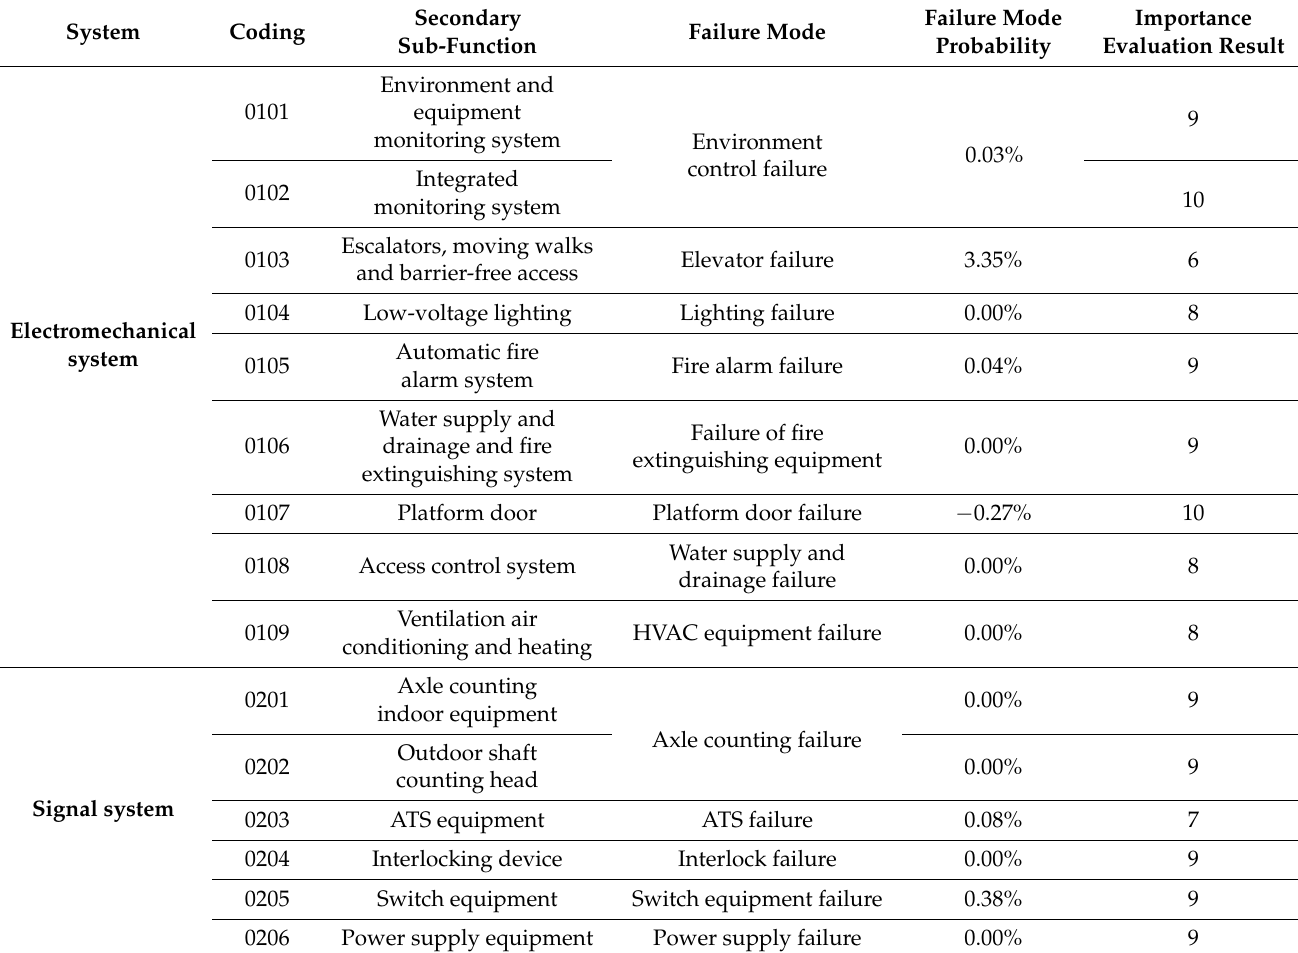
Table A1. The Comprehensive Analysis Results of the Changping